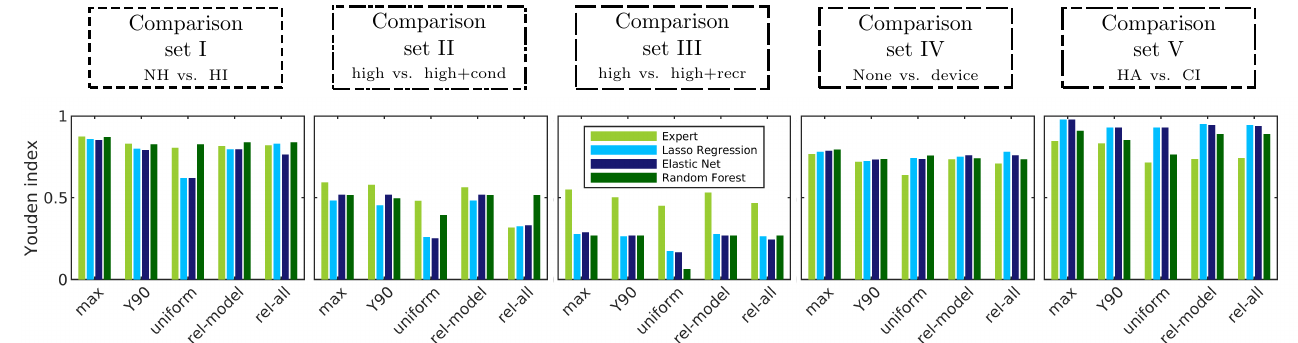
Figure 6. Youden index Y depicted for different comparison sets (panels), groups of CAFPA com- binations ( x -axis), as well as expert-estimated and model-predicted CAFPAs (colors, as introduced in Figure 4). Conditions on the x -axis comprise the maximum performance in the respective com- parison set and model, median performance in Y90 combinations (red data points in Figure 4), and performance using uniform , rel-model , and rel-all weights. For classification based on expert-estimated CAFPAs, rel-model and rel-all weights were estimated based on Y90 combinations for expert classifica- tion alone; hence, these are not common weights between expert and model, as depicted in Figure 5, but are depicted in